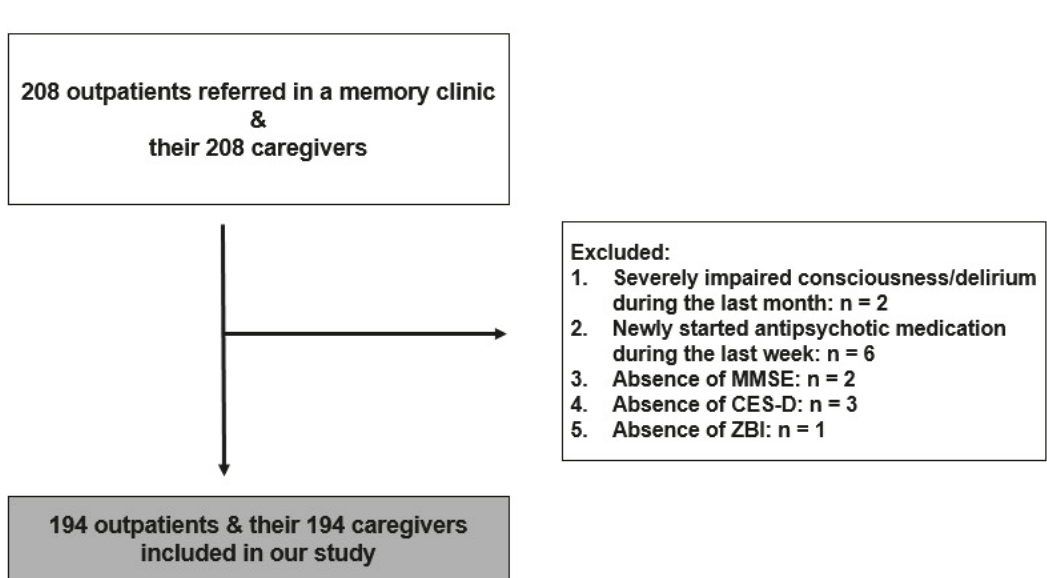
Figure 1: Flow chart with the participants of the present